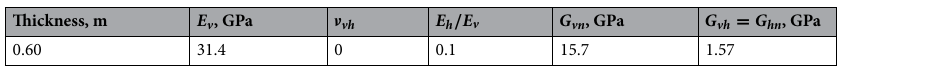
Table 3. Properties of plate elements adopted for r.c. diaphragm walls (v vertical direction; h horizontal direction contained in plate plan; n horizontal direction normal to plate plane).